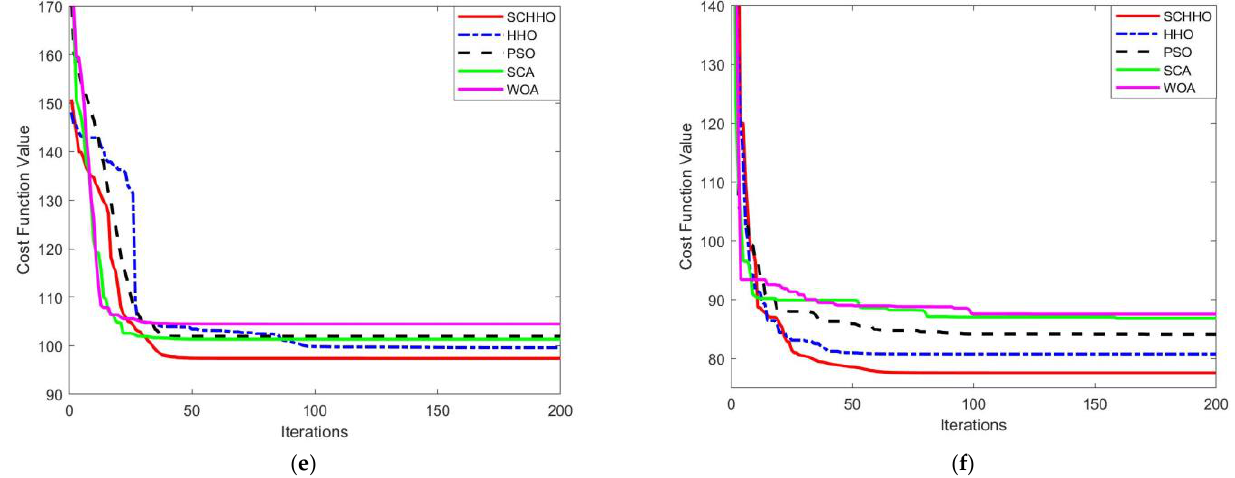
Figure A1. Convergence curves of five algorithms six benchmark functions when n = 30. ( a ) Sphere.